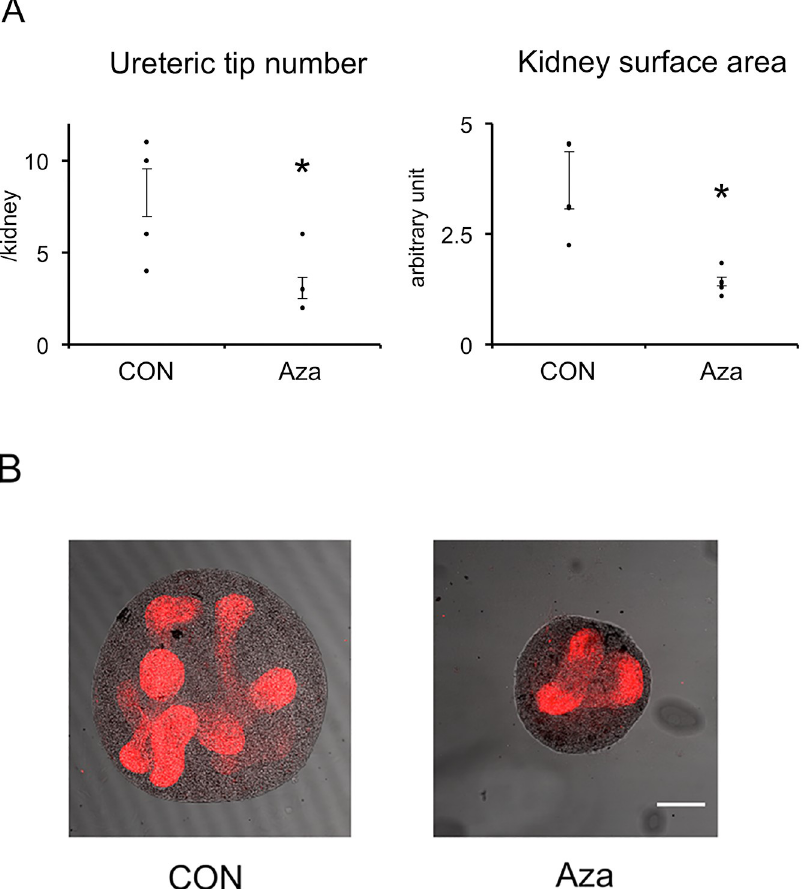
Ureteric buds were visualized by whole mount staining with anti-pancytokeratin antibody. (A) Quantitative analysis. n = 1 litter, n = 6 kidneys. Statistical analysis was performed with ANOVA followed by Tukey’s test. Bars represent ± SE. � , P < 0.05 vs CON. (B) Representative images. Scale bar, 250 μ m.